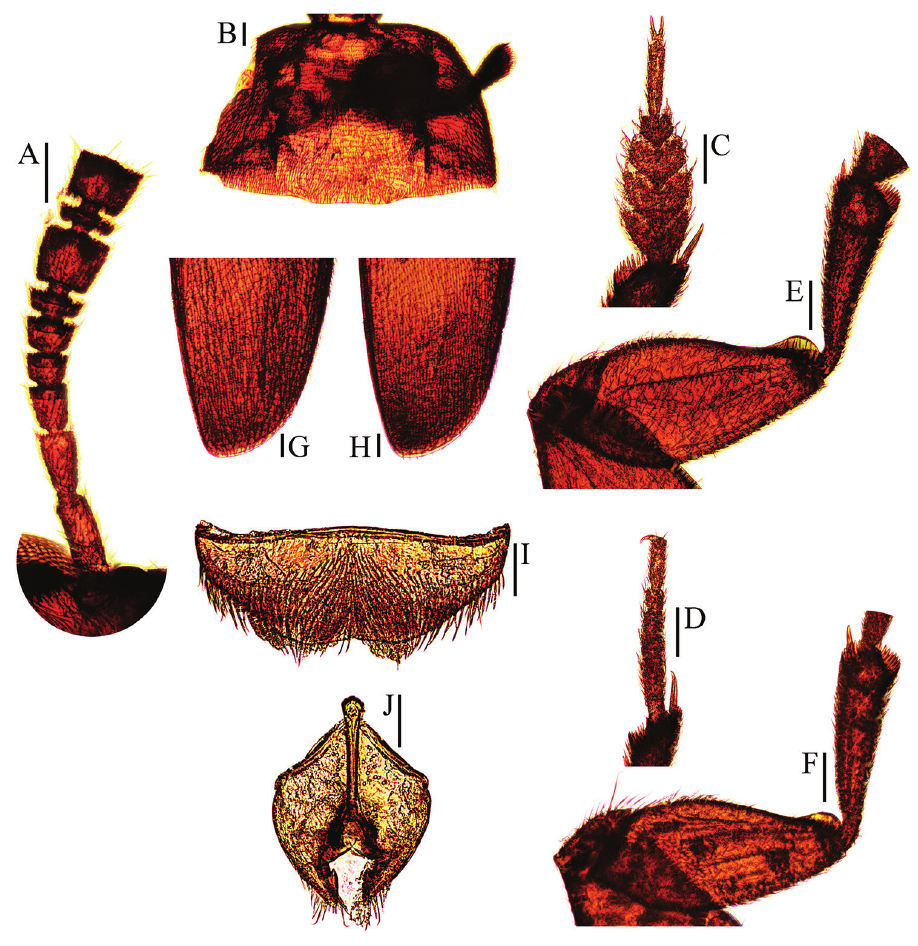
Figure 4. Ptomaphagus (s. str.) masumotoi Nishikawa, 2011 ( ♂ : paratype; ♀ : holotype). A antenna ♂ (dorsal view) B pronotum ♂ (dorsal view) C protarsus ♂ (dorsal view) D protarsus ♀ (dorsal view) E protibia and profemur ♂ (ventral view) F protibia and profemur ♀ (ventral view) G elytral apex ♂ (dorsoapical view) H elytral apex ♀ (dorsoapical view) I ventrite VIII ♂ (ventral view) J genital segment ♂ (ventral view). Scale bars: 0.1